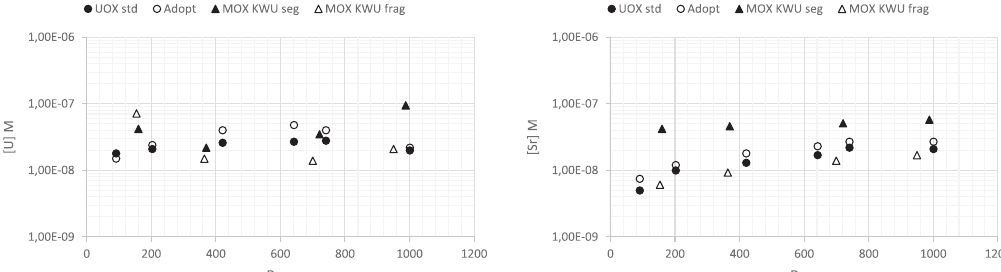
Fig. 6. Concentration in aqueous solution vs. time for standard fuel, doped fuel (Adopt), and MOX. Experiments with hydrogen overpressure (Studsvik: initially 50 bar hydrogen. KIT: initially 40 bar with 3,2 bar hydrogen). NB Only data after 90 days are shown on this plot. Data produced by Studsvik and KIT in the DisCo project.